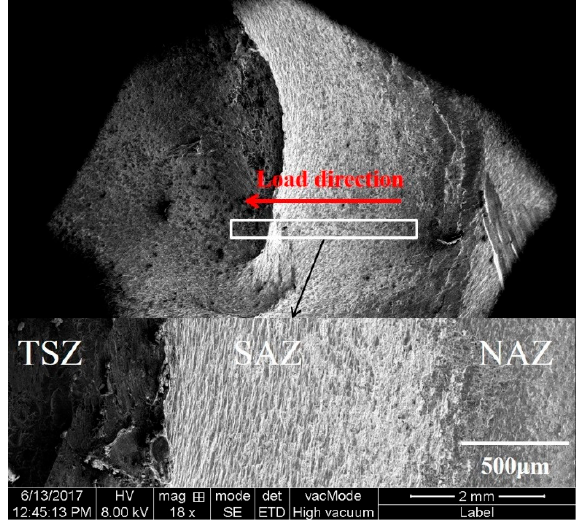
Figure 13. Load-displacement curves ( a ) and histogram of impact properties ( b ) of the dissimilar Al / steel keyhole-free FSSW joint.